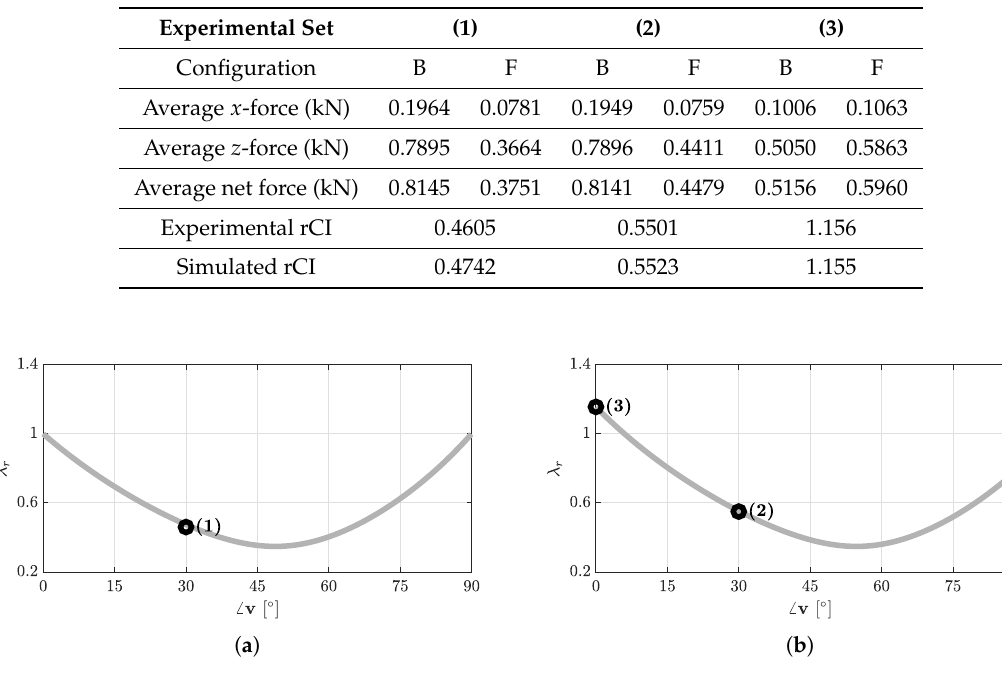
Figure 16. rCIs ( λ r ) in the case of ( a , b ): hollow circles and gray lines represent the experimental and simulated rCIs,